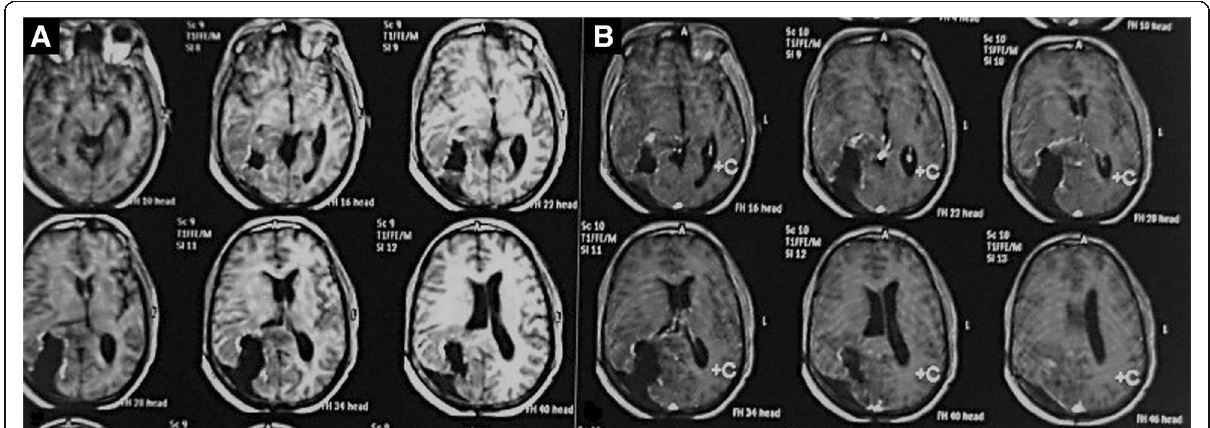
Fig. 5 Illustrative case, postoperative MRI axial T1WI: a without contrast and b with contrast